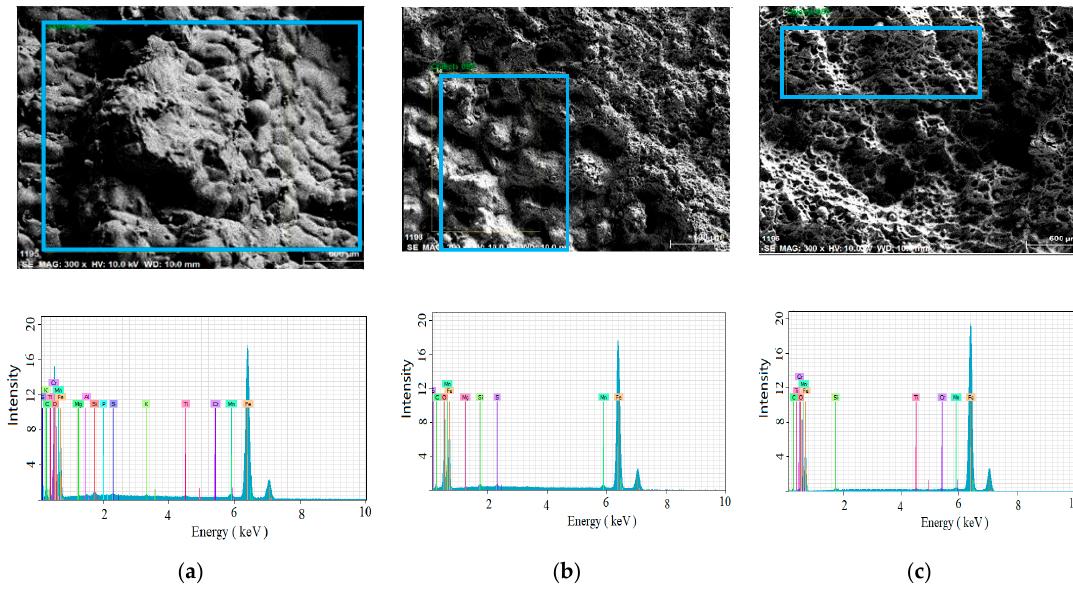
Figure 7. Elemental map of the ( a ) liquid-film region; ( b ) boundary region; and ( c ) dimple region. Table 2. Elemental compositions of the crack surface at different regions (wt. %). Element